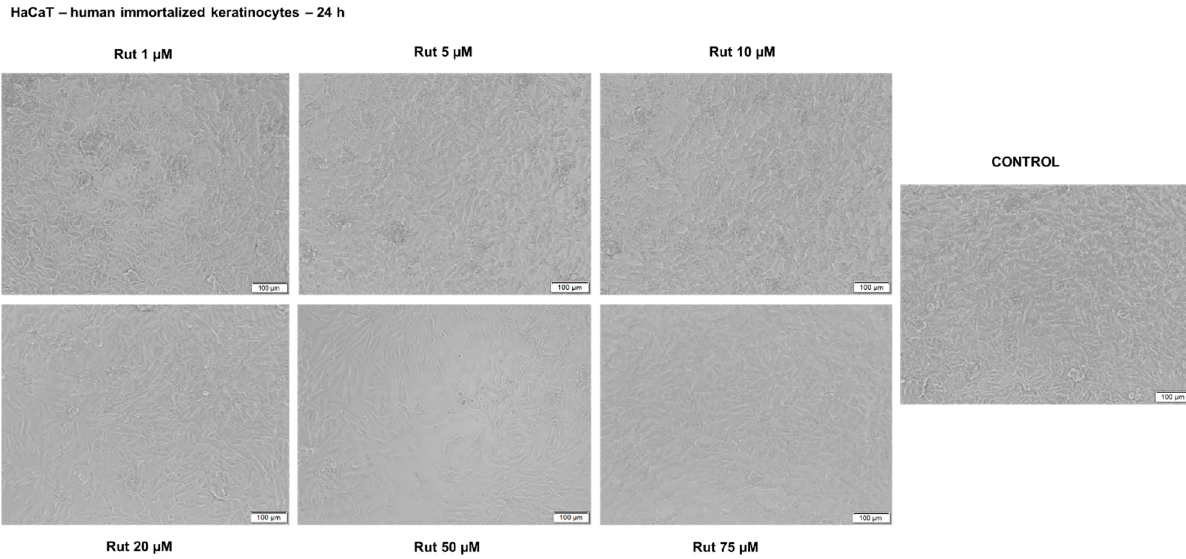
Figure 9. Morphological aspect of HaCaT cells after treatment with Rut (1, 5, 10, 20, 50 and 75 µM) for 24 h. The pictures were taken 24 h posttreatment. The scale bars represent 100 µm.